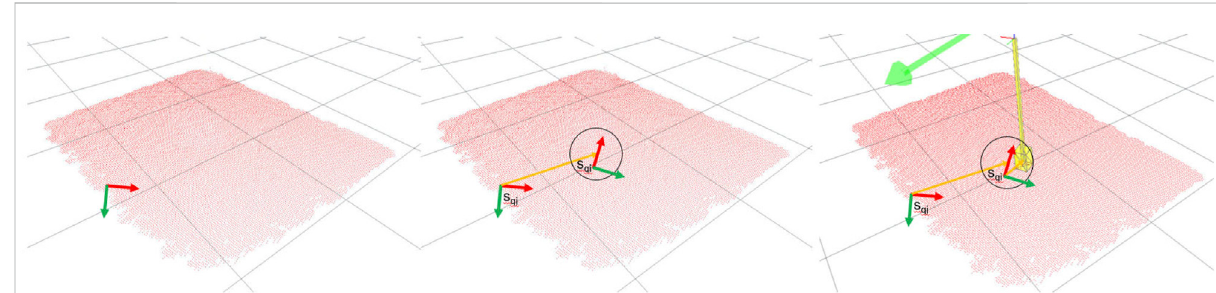
FIGURE 5 Graphical representation of inferring a candidate link pose for a novel surface. First, from the task model we sample a feature s qj on the novel point cloud. We then apply the transformation u ij observed when learning the model to identify a feasible contact region. From that region (circled areainthemiddleimage),wesampleasurfacefeaturefromtheobjectmodel O ( v , r ).Finallyweapplythetransformation u ni observedattrainingtime to place the link L n